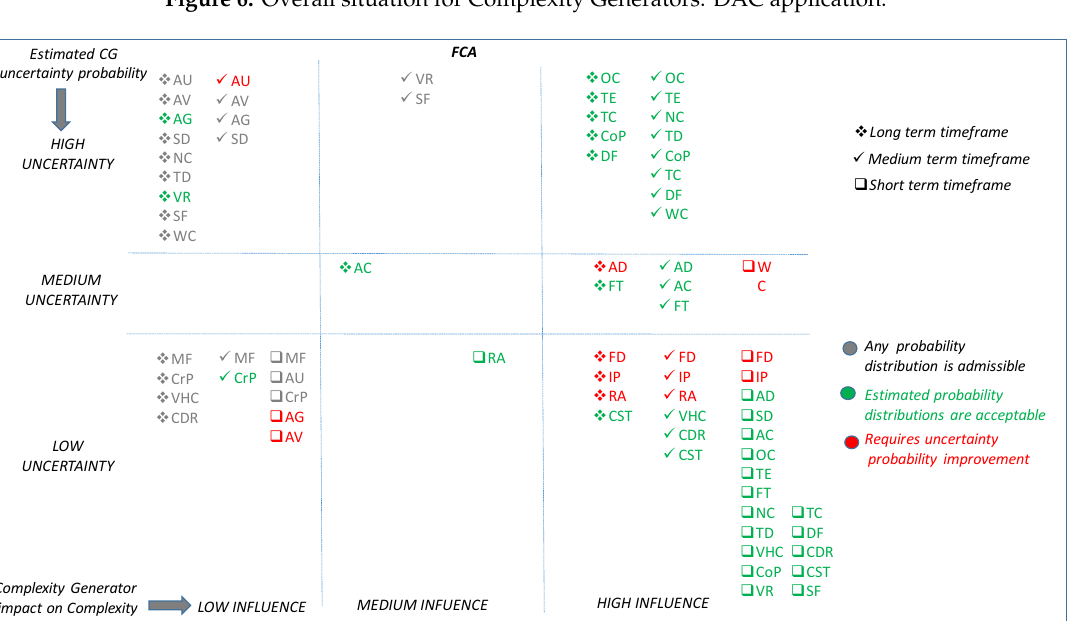
Figure 6. Overall situation for Complexity Generators. DAC application.